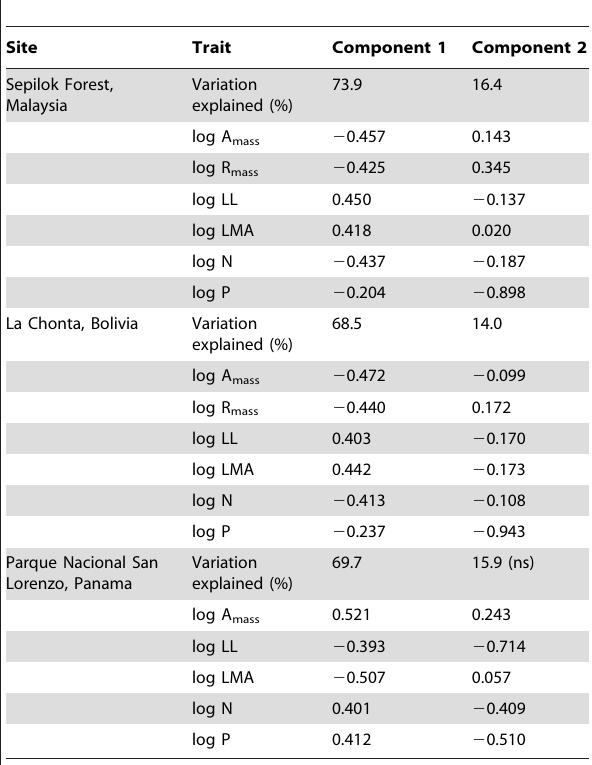
Table 1. Principal components analysis of leaf economics traits for Sepilok (16